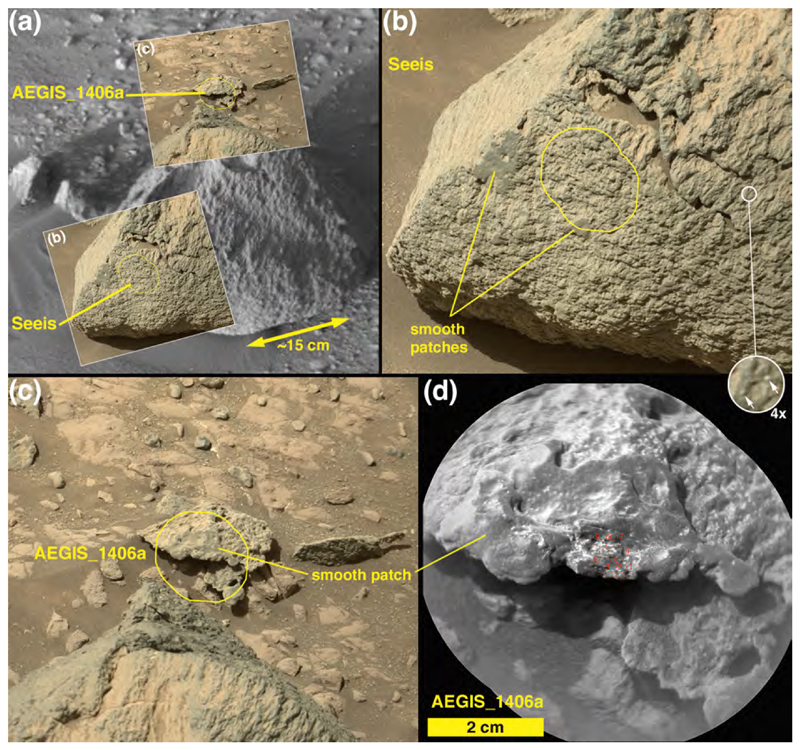
(a) Context for two ChemCam targets, Seeis and AEGIS_1406a, on two separate stones at Bimbe. (b) Seeis target; outline indicates location of ChemCam RMI coverage, 4× inset indicates examples of the largest (mm-scale) grains. (c) AEGIS_1406a target; outline indicates the location of the ChemCam RMI coverage shown to the right. (d) Close-up view, with crosshairs indicating LIBS observation points on AEGIS_1406a.